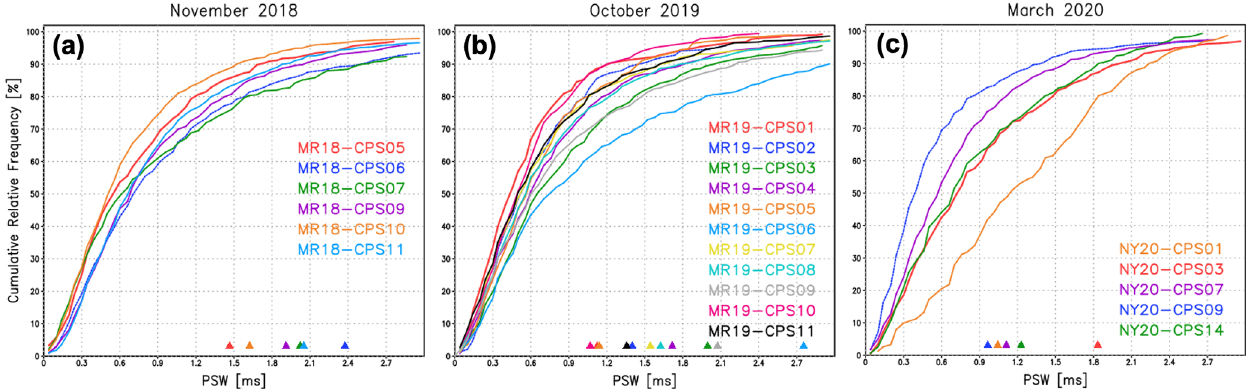
Figure 5. Accumulated relative frequency of PSW for (a) November 2018, (b) October 2019, and (c) March 2020. Each triangle indicates the cutoff PSW (PSW c ).